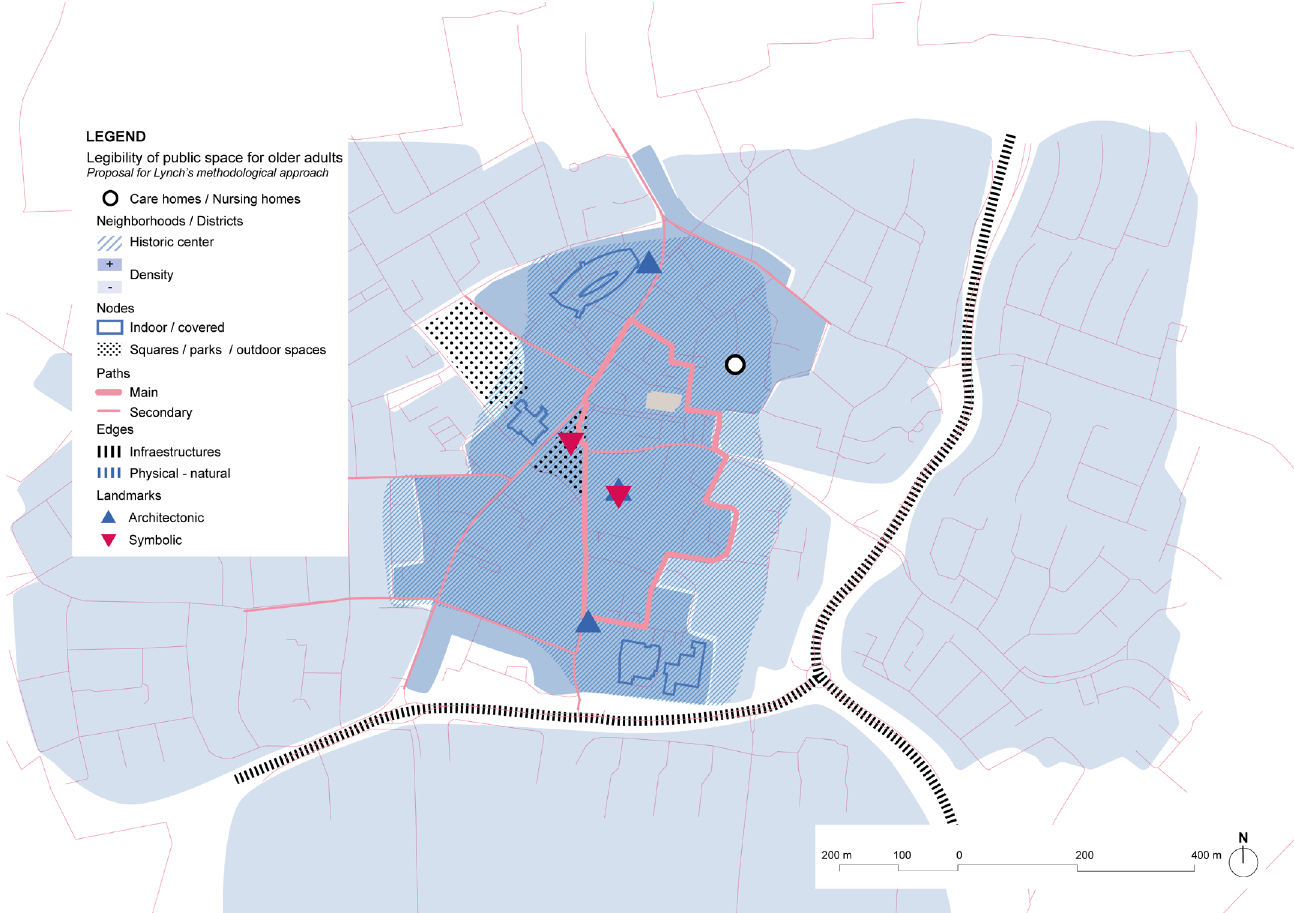
Figure 26. Scheme of the Nuenen’s Kwiek Beweegroute project and its environmental context based on Lynch’s theory. Source: Own elaboration.